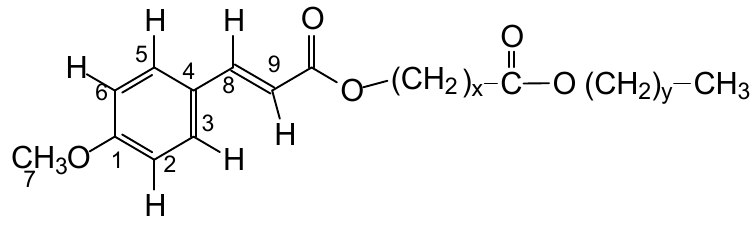
Figure 2. Structural representation of 4-methoxycinnamic acid diester (PCO-C). Table 3. Chemical shift, 1 H-NMR spectral data of 4-methoxycinnamic acid diester (PCO-C) with the corresponding numbering.